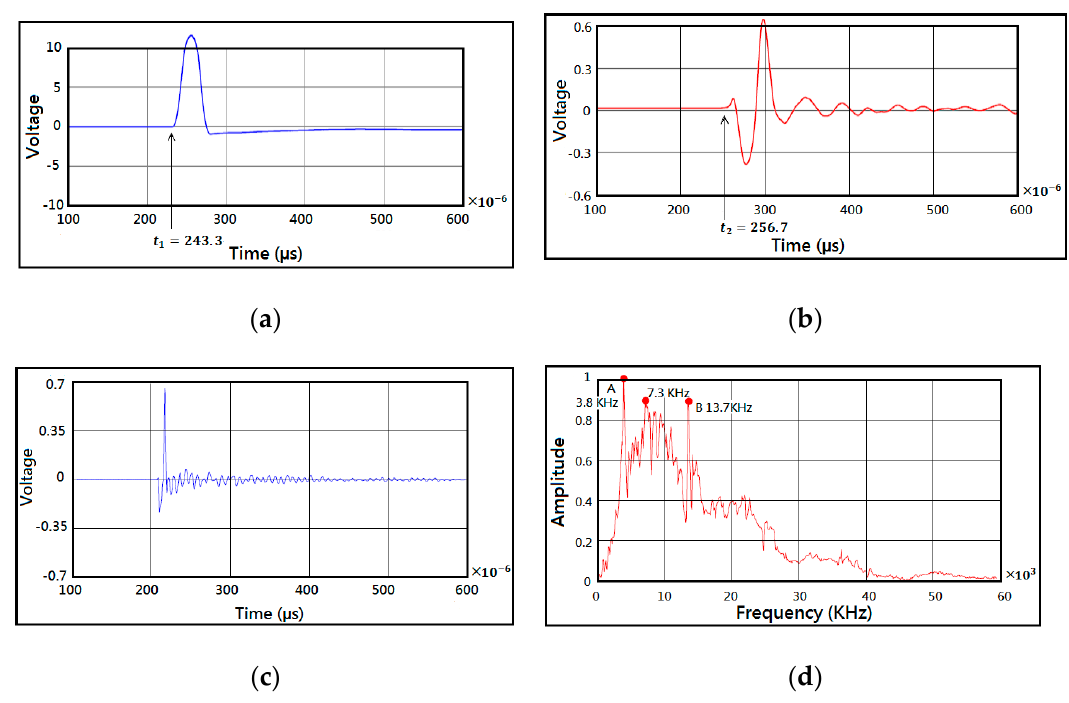
Figure 13. Impact wave graph of Object 3 with a crack depth of 12 cm: ( a ) incident impact point wave graph; ( b ) first reflected wave waveform graph; ( c ) MATLAB simulation graph; ( d ) spectrogram.